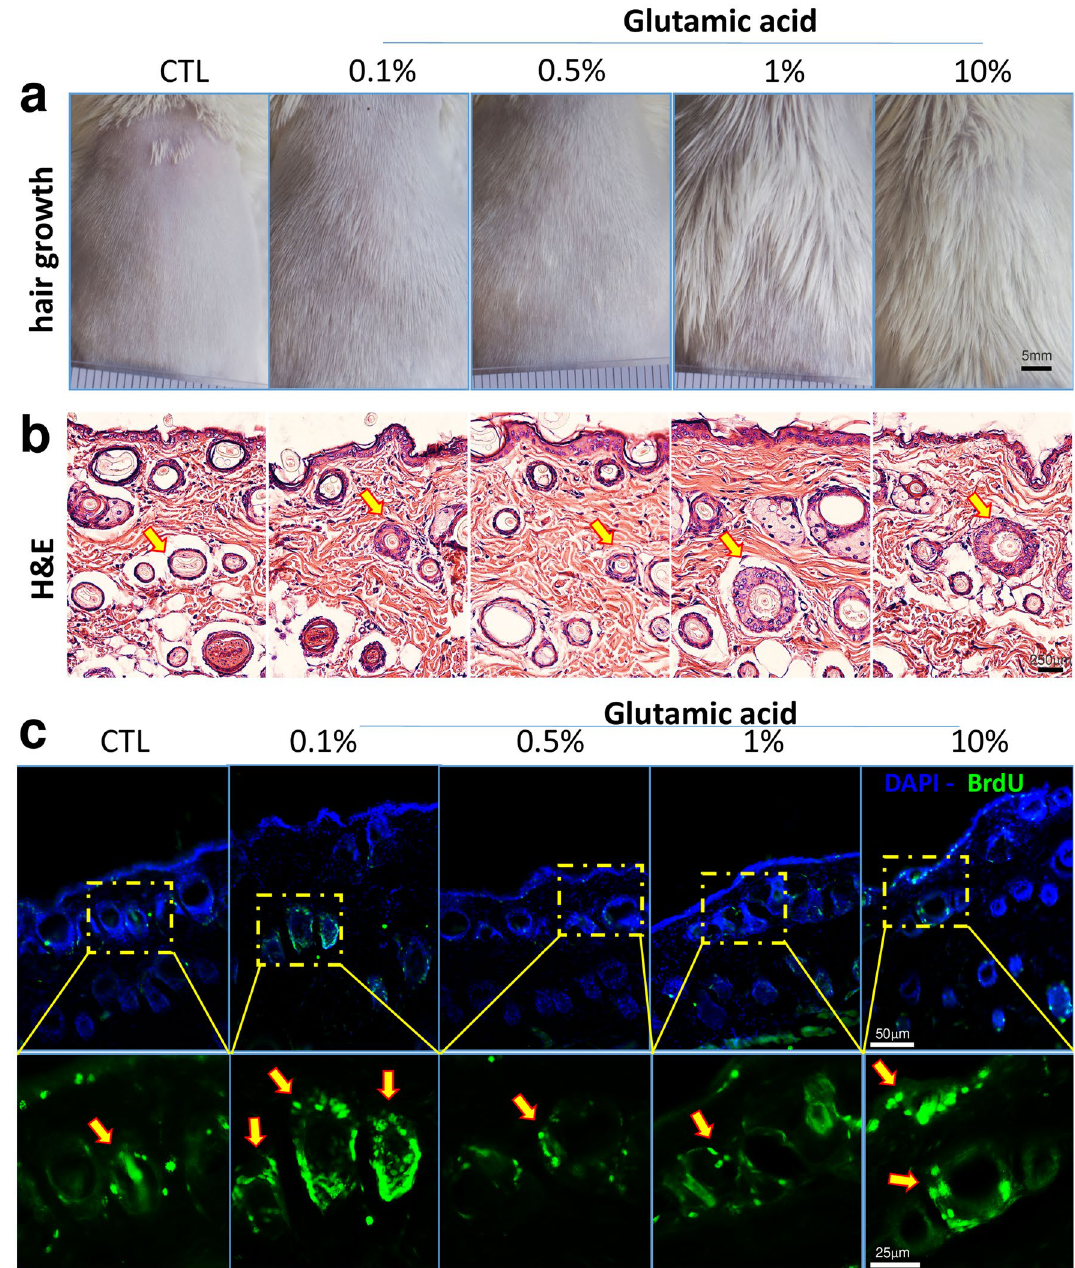
Figure 3. GA stimulates hair growth and increased BrdU + cells. Dose–response results of topical GA application on the dorsal region of mice with Vaseline (CTL) or 0.1%, 0.5%, 1% and 10% GA for 14 days ( a – c ). 5–6 animals per group. Hair growth effect after 14 days of GA treatment on the back of Swiss mice ( a ). Haematoxylin and Eosin (H&E) staining sample of the back of 14 day treated mice (hair follicle pointed with yellow arrows), scale bar 250 μm, samples from 3 different animals ( b ). Immunostaining results of skin samples treated 0.1%, 0.5%, 1%, and 10% Glutamic acid compared to Control group (Vaseline) ( c ). Immunostaining results of skin samples from 3 different animals, GA topical treatment for 14 days and, finally, 2 h with intraperitoneal BrdU. Yellow arrows indicate BrdU +